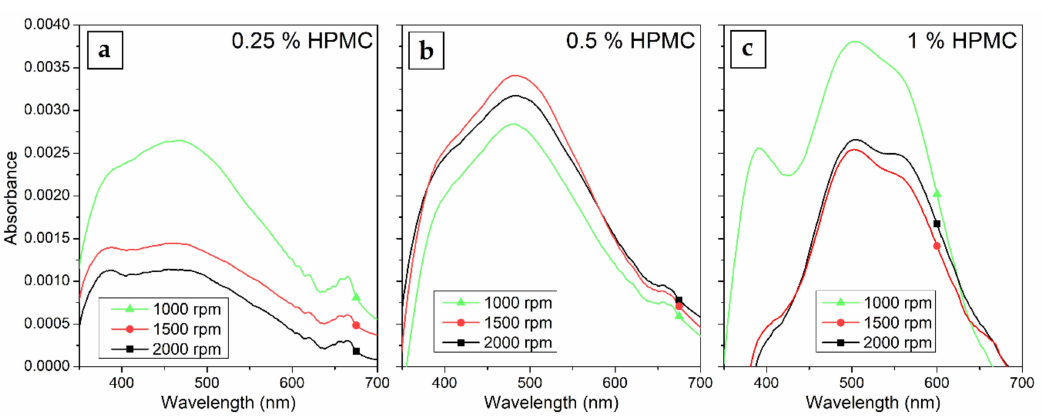
Figure 10. UV–Vis absorption spectra of the composite HPMC–AgNP spin-coated thin films prepared